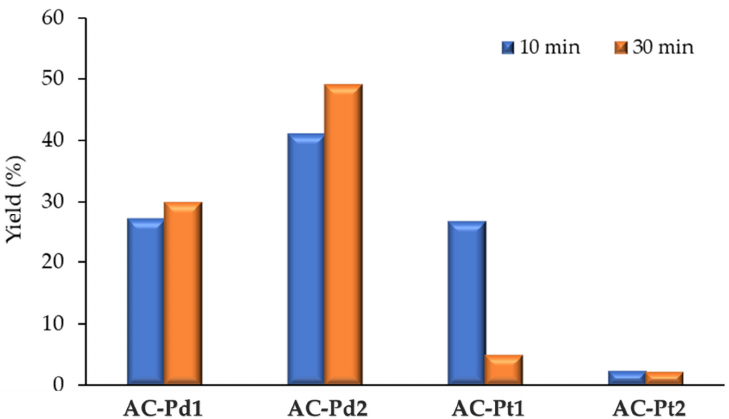
Figure 6. Cross-coupling Suzuki-Miyaura reaction of bromobenzene and phenylboronic, catalyzed by AC-Pd1, AC-Pd2, AC-Pt1, and AC-Pt2 composites. Reaction conditions: 2.5 mg catalyst, 0.6 mmol PhB(OH) 2 , 0.5 mmol PhBr, 1.0 mmol K 2 CO 3 , 2 mL EtOH, Ball mill: 10 milling spheres, 500 rpm,